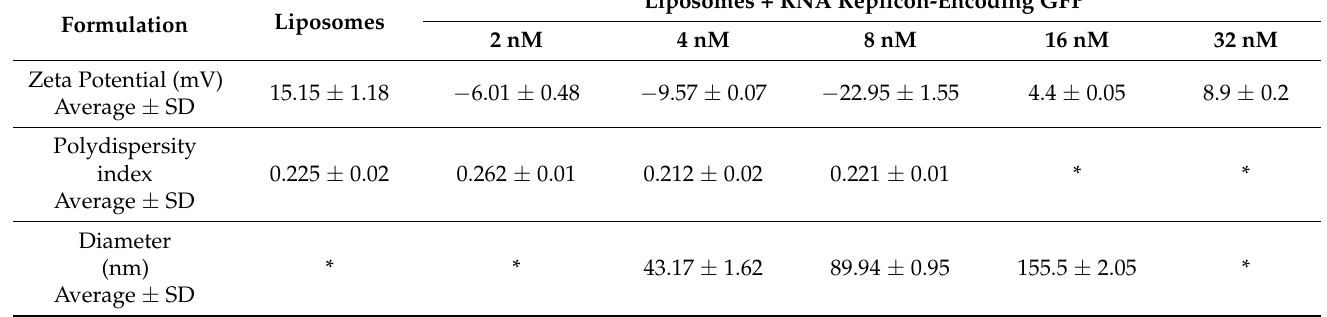
Table 1. Zeta Potential, polydispersity and diameter of formulated liposomes at different molar ratios. Measurements were performed in triplicate with cationic liposomes alone or encapsulating 1 µ g of RNA replicons encoding GFP with increasing concentrations of liposomes. Unstable ranges of measurements are marked with